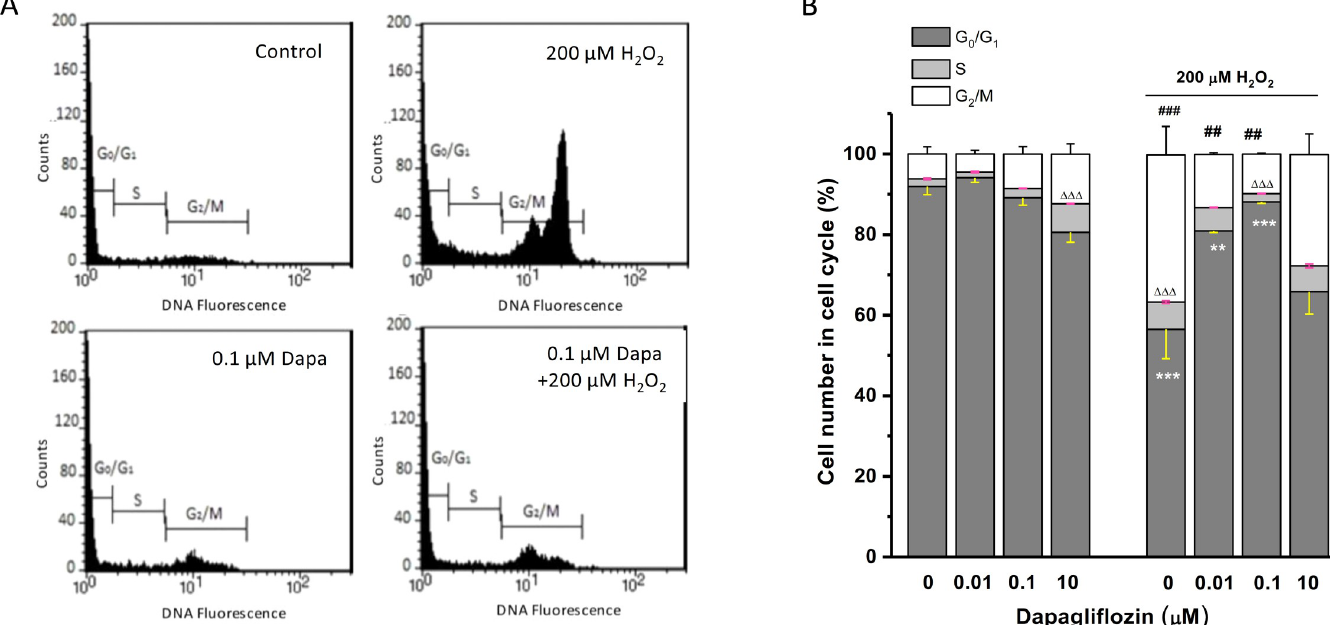
Fig 4. Cell cycle response to oxidative stress and the effect of dapagliflozin. A, Human proximal tubular cells (HK-2) were cultured in 6-cm petri dishes and the oxidative stress was induced with 200 μ M H 2 O 2 for 24 hours. The histogram examples of the cells stained with propidium iodide with or without 0.1 μ M dapagliflozin (Dapa). B, Cell cycle was quantified by FACS and mean ± SEM data were presented ( n = 3). One-way ANOVA with Bonferroni post hoc test was used for group comparison. �� P < 0.01 and ��� P < 0.001 for G0/G1 phase comparison; ΔΔΔ P < 0.001 for S phase comparison; and ## P < 0.01 and ### P < 0.001 for G2/M phase